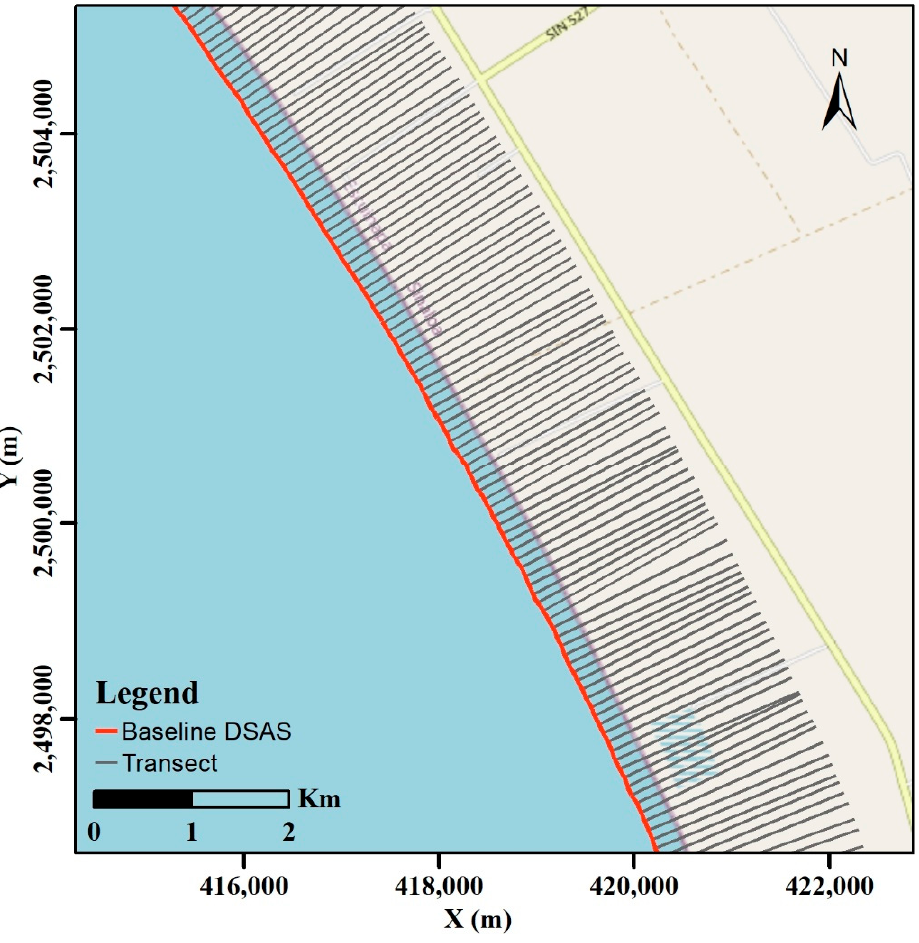
Figure 3. Example of transects and baseline.